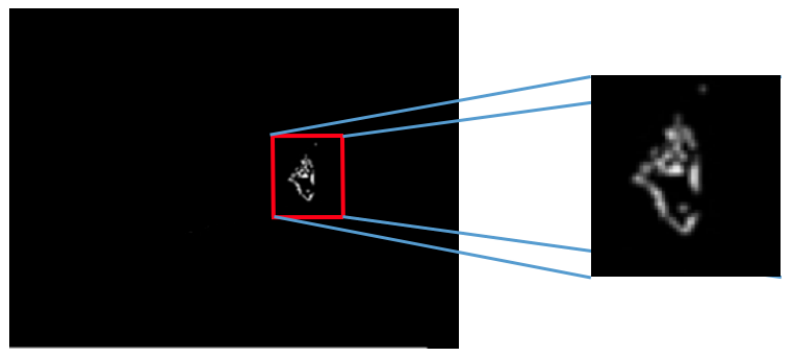
Figure 19. Hottest region detected for Case 3 resembling an angiogenesis